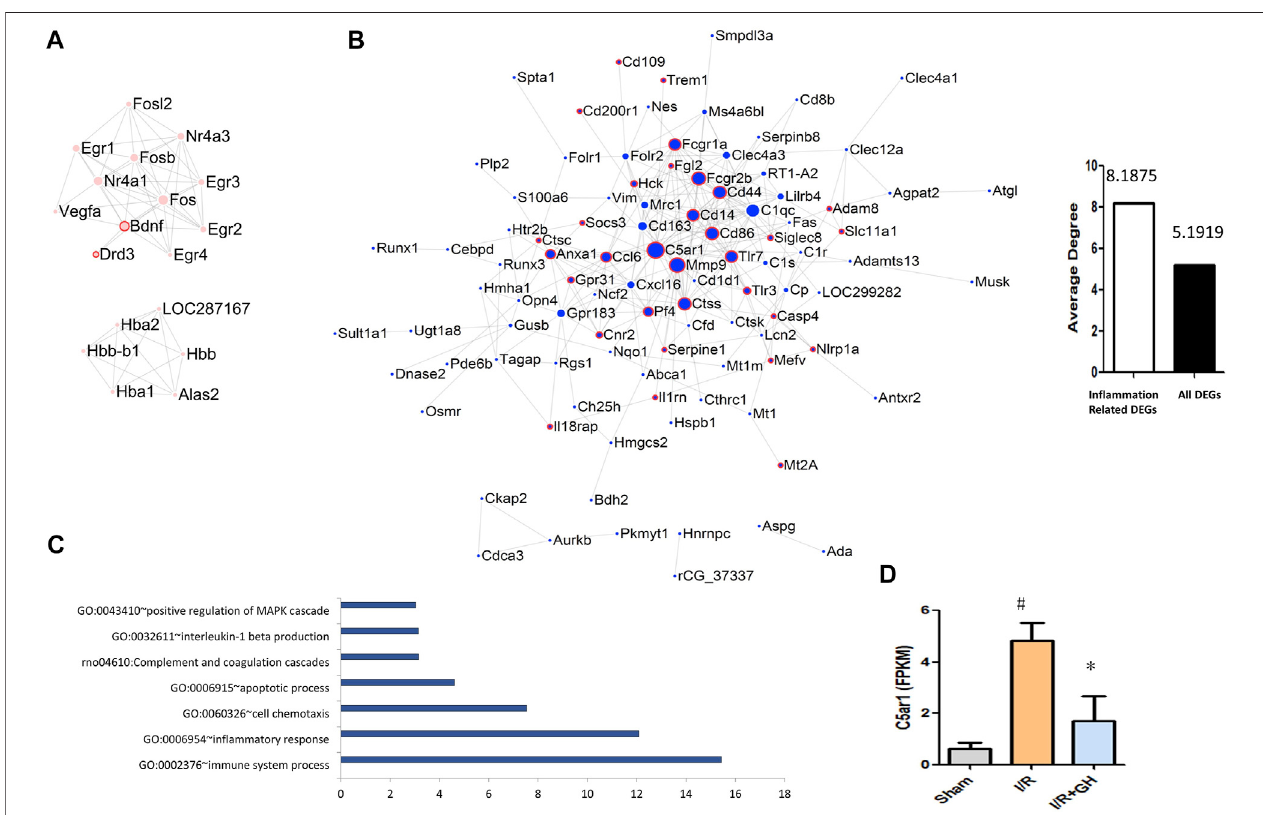
FIGURE4| FurtheranalysisandnetworkofDEGsbetweenI/R+GHandI/R. (A) ThenetworkofDEGsthatweresigni fi cantlydownregulatedafterI/Rtreatmentand werefurthersigni fi cantlyupregulatedbyGHI; (B) thenetworkofDEGsthatweresigni fi cantlyupregulatedafterI/Rtreatmentandwerefurthersigni fi cantlydownregulated by GHI, the red frame indicates that the DEGs were associated with the in fl ammation process; (C) the enriched biological process of the DEGs that were upregulated after I/R and then downregulated by GHI; and (D) the expression level of C5AR1 by RNA-seq identi fi cation # p < 0.05 compared with sham, * p < 0.05, compared with the I/R group. The expression of C5AR1 and C5A was reduced by GHI.